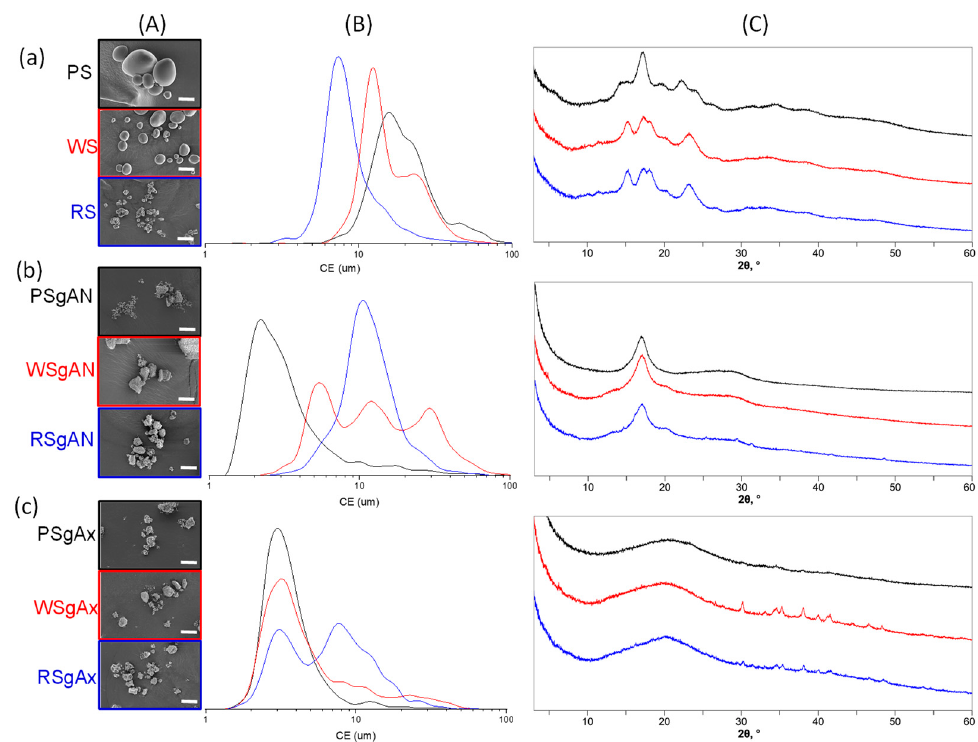
Figure 1. SEM images (scale bar 20 µm) ( A ), circular equivalent (CE) diameter ( B ) and X-ray diffrac- tograms ( C ) of initial ( a ) and grafted AN ( b ) and Ax ( c ) starches.